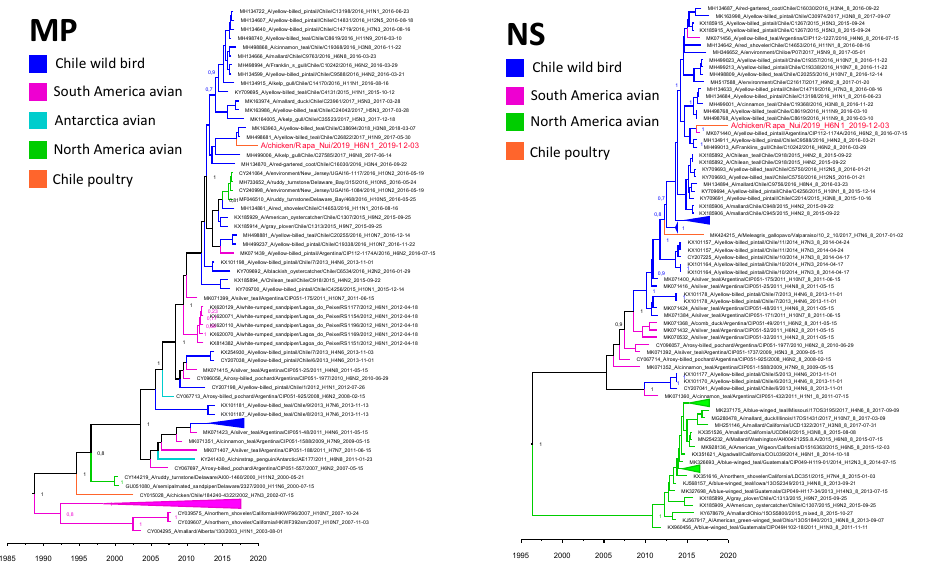
Figure 2. Bayesian MMC trees for each of the internal genes of A/Chicken/Rapa Nui/CT2170/2019. Time stamped trees that show temporal and phylogenetic relationships between the virus obtained in Rapa Nui (tip text in red) to Chilean, South American, Antarctician, and North American AIV’s. Node labels indicate the posterior probability of the node. Collapsed nodes indicated with